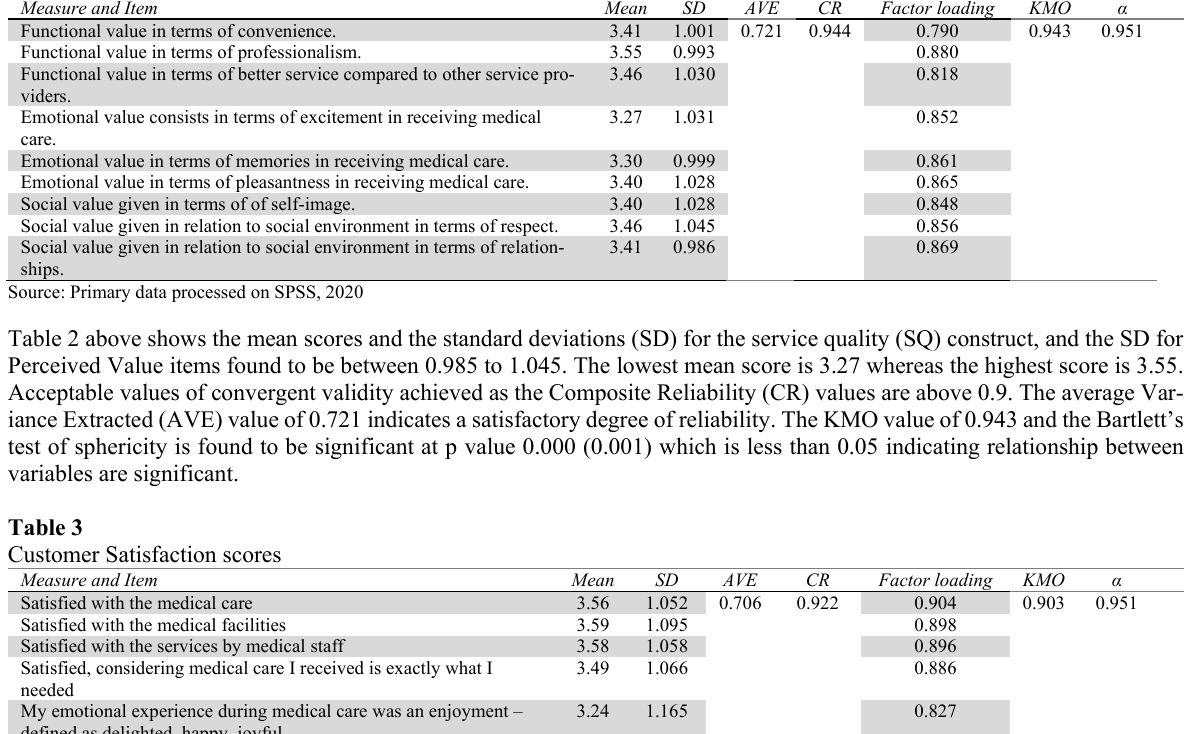
Perceived value scores Measure and Item